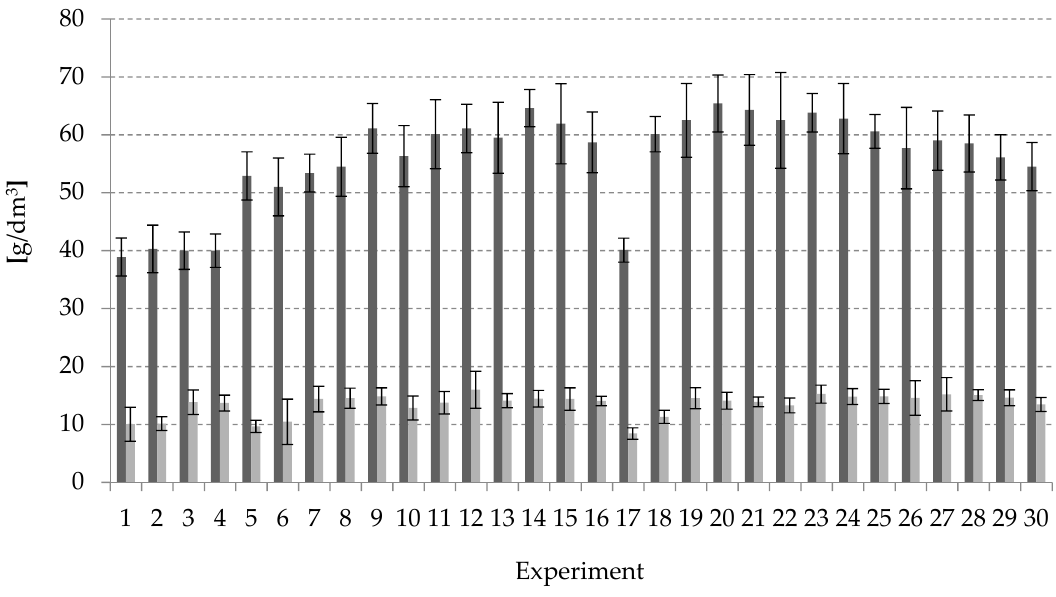
Figure 2. Biomass dry cell weight (DCW) and DHA concentrations obtained in the experimental series designed using the response surface methodology. Table 8. Effect of variables on DCW and DHA concentrations, with related statistical test results.